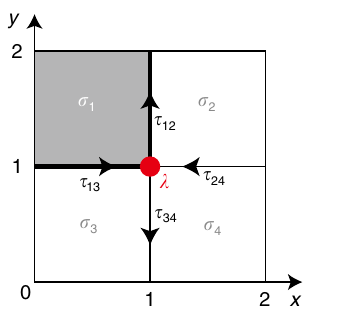
Fig. 4 Cell decomposition for two wallpaper groups. a Cell decomposition for the p2mm wallpaper group. M x , M y and C 2 denote the two mirror re fl ections and the two-fold rotation. b Cell decomposition for the p2 group. C 2 denotes the two-fold rotation.